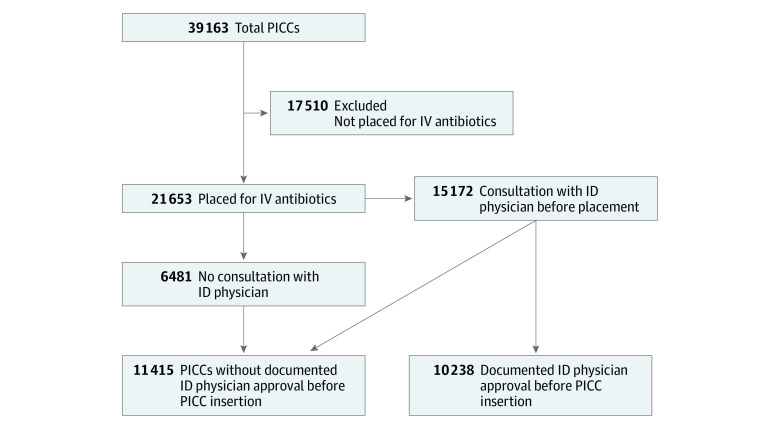
Patient Inclusion Flow DiagramID indicates infectious disease; IV, intravenous; and PICC, peripherally inserted central catheter.